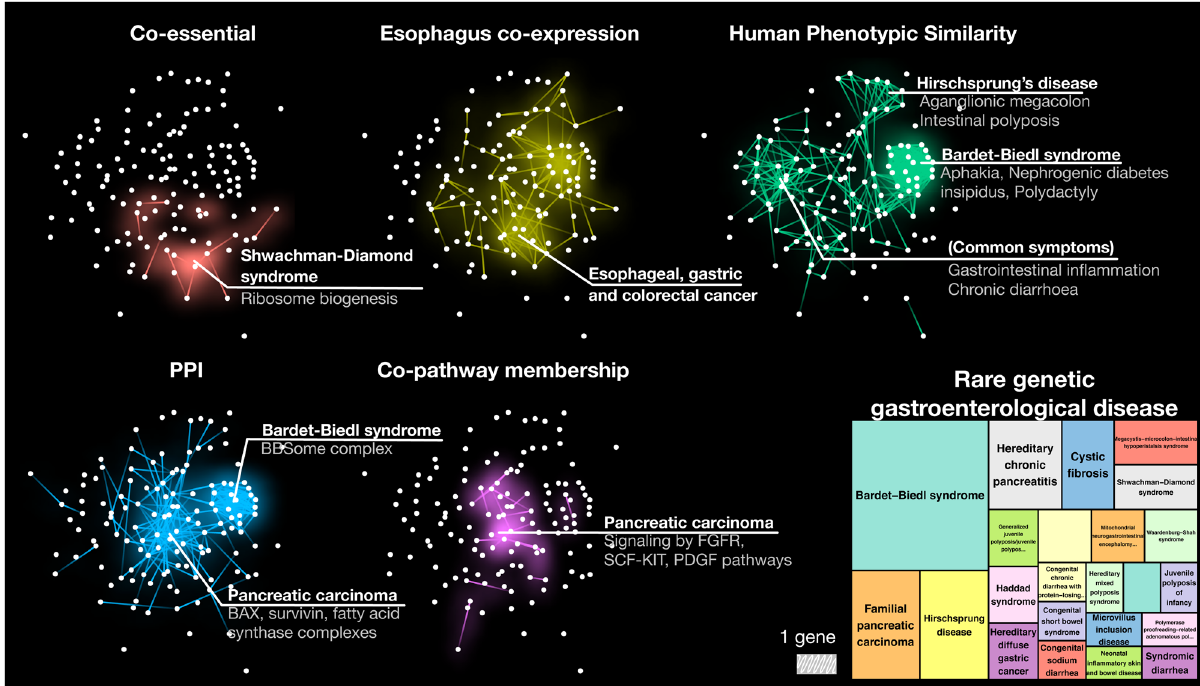
Fig. 4 Network modules of rare genetic gastroenterological diseases across different levels of biological organization. Genes implicated in rare gastroenterological disease form signi fi cant modules on fi ve network layers (compare with Fig. 3), which capture relevant relationships on different scales. Diseases in the disease group exhibit unique connectivity patterns in the network layers where their disease characteristics can be derived. For example, a strong phenotypic cluster of Bardet-Biedl syndrome genes can be derived from the protein complex (BBSome) whose defects lead to cilia dysfunction, while pancreatic carcinoma cluster is most observable on the pathway level where its causal genes interact physically and are also member of crucial signaling pathways. The treemap represents disease entries in Orphanet (leaf terms with at least two gene associations) that belong to the rare genetic gastroenterological disease group (69 diseases with only one gene association are not shown